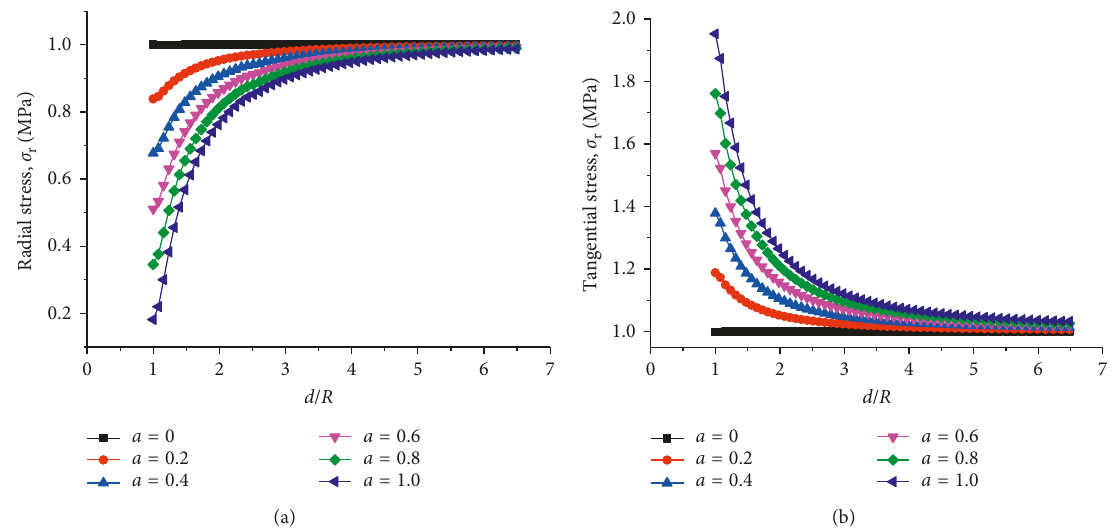
Figure 8: Effect of full-face anchorage on the stress distribution of surrounding rock with different stress release coefficients. (a) Radial stress. (b) Tangential stress.